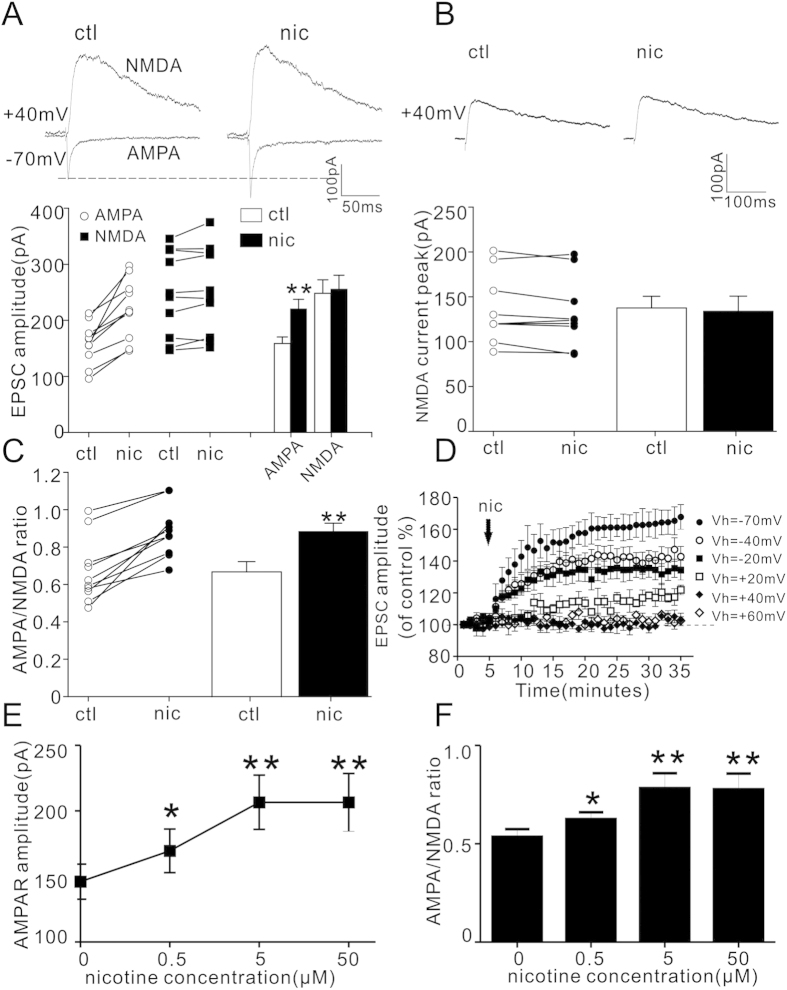
Nicotine increases AMPA/NMDA ratio but not NMDA current in PFC layer I neurons.(A) Representative traces of evoked EPSC at +40 mV (mixed NMDA) and −7 0mV (AMPA) in the absence (ctl) and presence (nic) of nicotine (5 μM) are shown on the top; Dot plots and histograms summarizing the amplitude of AMPA current and NMDA current are shown on the bottom. The amplitude of NMDA current was measured at 50ms post-stimulus at +40 mV. **P < 0.001 (nicotine vs. control in the same cell, paired Student’s t-test, n = 10). (B) Representative traces of NMDA current (in the presence of 20μM CNQX and 10μM bicuculine) at +40 mV before (ctl) and after nicotine (nic) are shown on the top; Dot plots and histograms summarizing the peak amplitude of NMDA current from top traces are shown on the bottom (P = 0.566, nicotine vs. control in the same cells, paired Student’s t-test, n = 8). (C) Dot plots and histograms of APMA/NMDA ratio from A before (ctl) and 10 min after nicotine (nic, 5 μM) application (**P < 0.001, nicotine vs. control in the same cell, paired Student’s t-test, n = 10). (D) Time course of the evoked EPSC amplitude before and after nicotine (5 μM) at holding potentials of −70 (n = 7), −40 (n = 5), −20 (n = 5), +20 (n = 5), +40 (n = 5) and +60 mV (n = 5), respectively. Nicotine causes vary degrees of current enhancement at these holding potentials, except at +40 and +60 mV. (E,F) Dose-response relationship of AMPA current (E) and AMPA/NMDA ratio (F) at nicotine concentration of 0, 0.5, 5 and 50 μM, respectively. *P < 0.05, **P < 0.01 (nicotine vs. control in the same cells, paired Student’s t-test, n = 7).